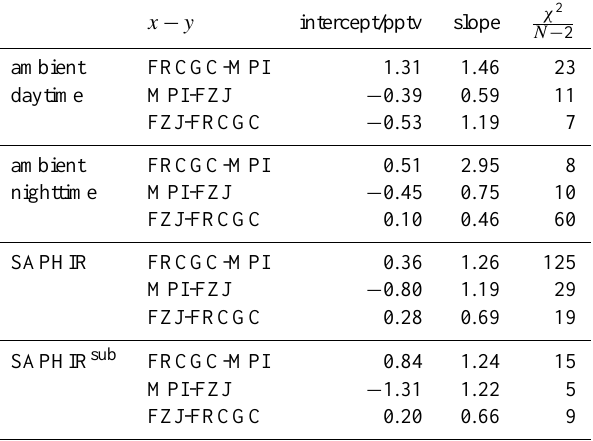
Table 4. Results of the linear regression analysis between HO 2 data 2 of the different instruments. χ is the sum of squared residuals N − 2 divided by number of data points. Data are averaged to 1min time intervals and the standard deviation is taken as error, unless the error propagation of the high resolution data was larger than the standard deviation. Data after noon on 22 July were excluded (see text for